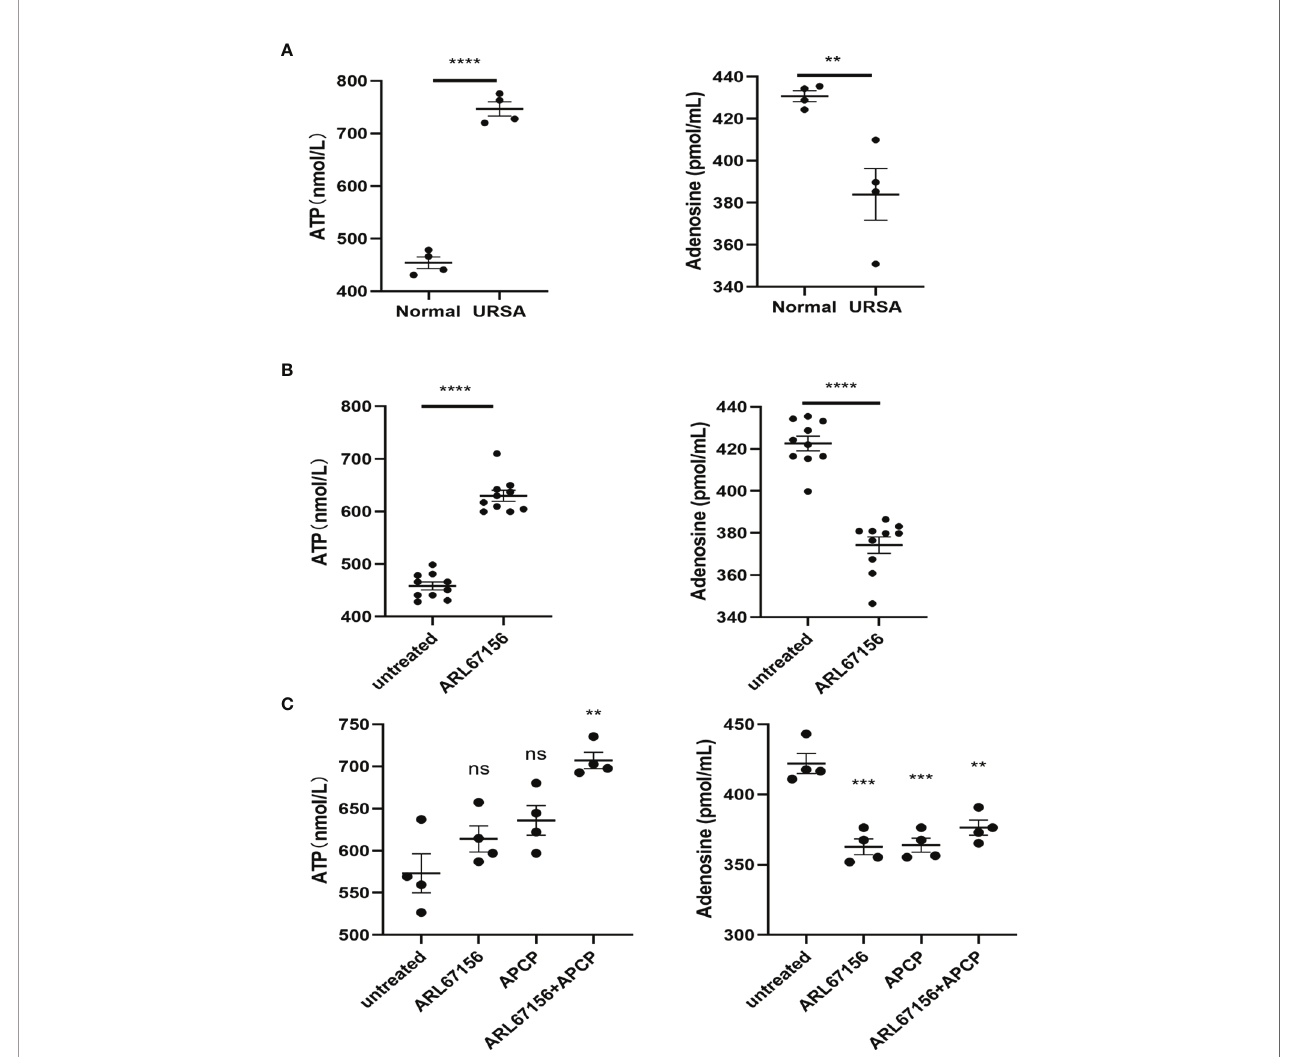
FIGURE 2 | Production of ATP and adenosine in dNK cells. (A) dNK cells were isolated from decidual tissues of normal pregnant women (n=4) and URSA patients (n=4), and then cultured in a 24-well plate (2 × 10 5 cells/well) for 24 hours. The concentrations of ATP and adenosine in the media were measured using ELISA (mean ± SEM, ****P < 0.0001, two-tailed t tests). (B) Freshly prepared dNK cells (n=10) were isolated from healthy decidua and incubated in the absence or presence of CD39 inhibitor (ARL67156) in a 24-well plate (2 × 10 5 cells/well) for 24 hours. The concentrations of ATP and adenosine in the media were measured using ELISA (mean ± SEM, **P < 0.01, ****P < 0.0001, two-tailed t tests). (C) dNK cells isolated from healthy decidua (n=4) were co-cultured with HTR-8/SVneo cells (dNK cells:HTR-8/SVneo cells = 2:1) and incubated in the absence or presence of the CD39 inhibitor ARL67156 and/or the CD73 inhibitor APCP in a 24-well plate (2 × 10 5 cells/well) for 24h. The concentrations of ATP and adenosine in the media were measured using ELISA (mean ± SEM, ns, statistically not signi fi cant, **P < 0.01, ***P < 0.001 compared with the untreated group, one-way ANOVA and post hoc